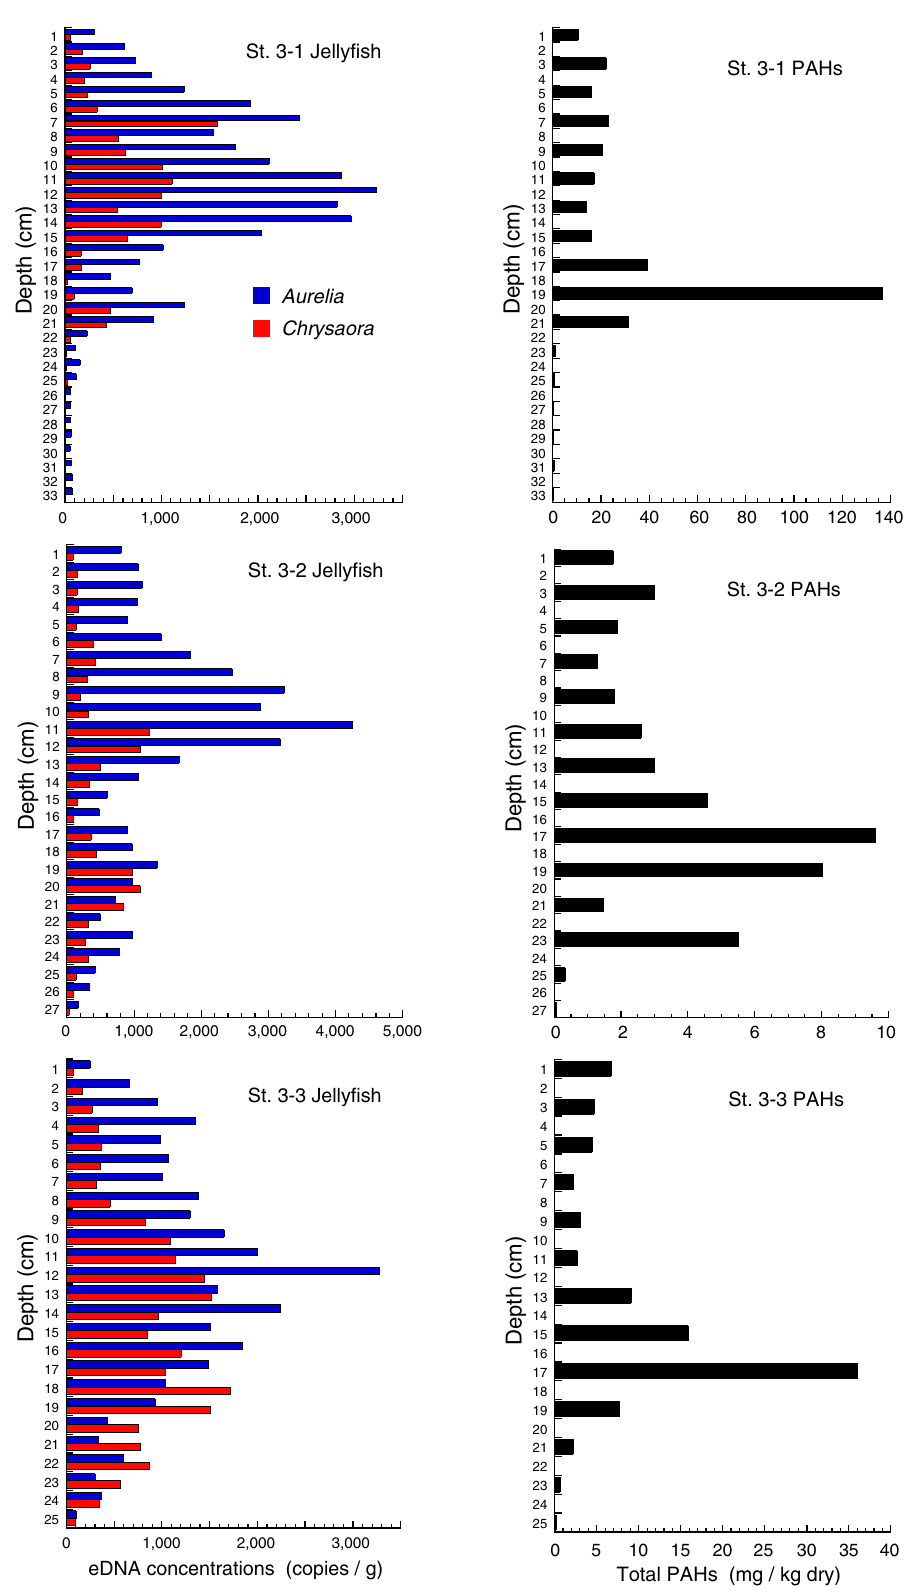
Figure 7. Concentrations of moon jellyfish ( Aurelia sp.) and sea nettle ( Chrysaora pacifica ) eDNA and polycyclic aromatic hydrocarbons (PAHs) analyzed from samples of the sediment cores collected at St. 3 in Moune, Kesennuma, northeast Japan. Both eDNA and PAHs were analyzed for all three